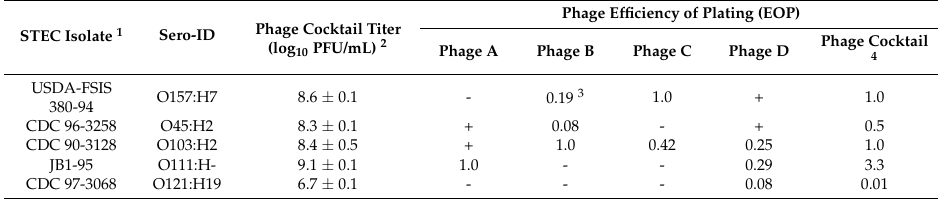
Table 1. Phage titer and efficiency of plating characterization of Shiga-toxigenic E. coli (STEC) by